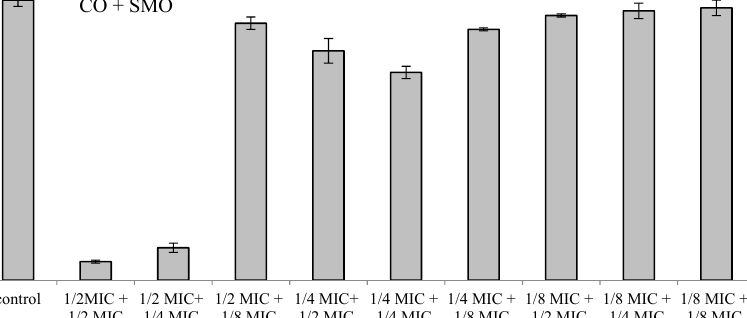
Figure 2. Changes in OD 600 for an L. monocytogenes culture with mixtures of essential oils (EOs) after 24 h. SOO—Spanish origanum oil, SMO—Spanish marjoram oil, CO—coriander oil. A FICI value of 0.5 (Table 3) was observed only for two mixtures, SOO + SMO and SOO + CO in a ¼ MIC + ¼ MIC combination, suggesting a synergistic effect of the components of the EOs in these